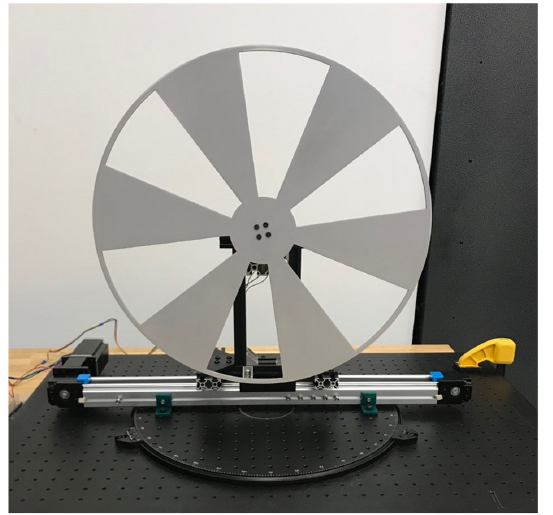
Figure 7. Radial motion device with a Siemens Star mounted to a rotating optical